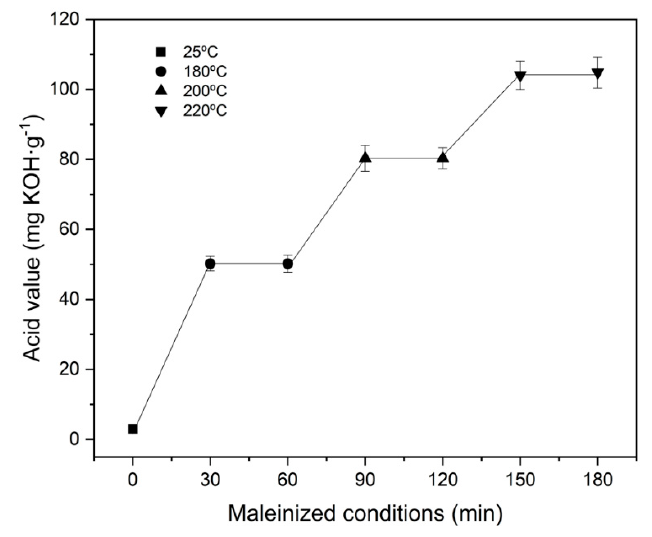
Figure 2. Effect of temperature and time on the efficiency of the maleinization.